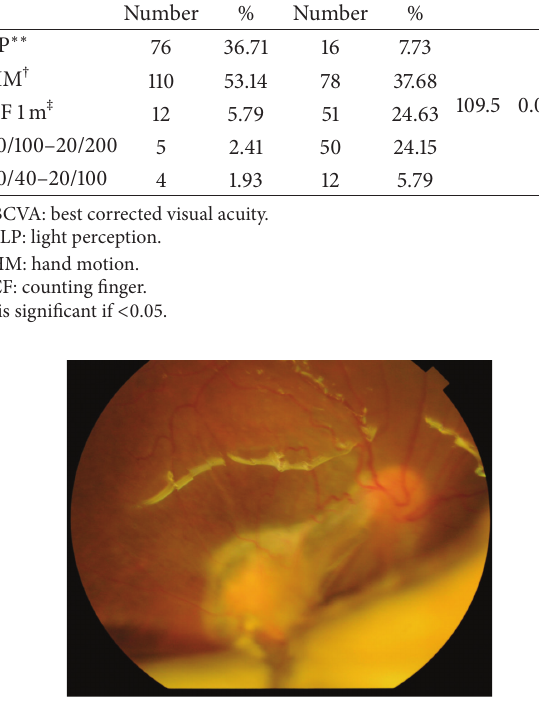
Figure 4: Color photo of right eye showing retinal incarceration at the exit site and lower RD under silicon oil.